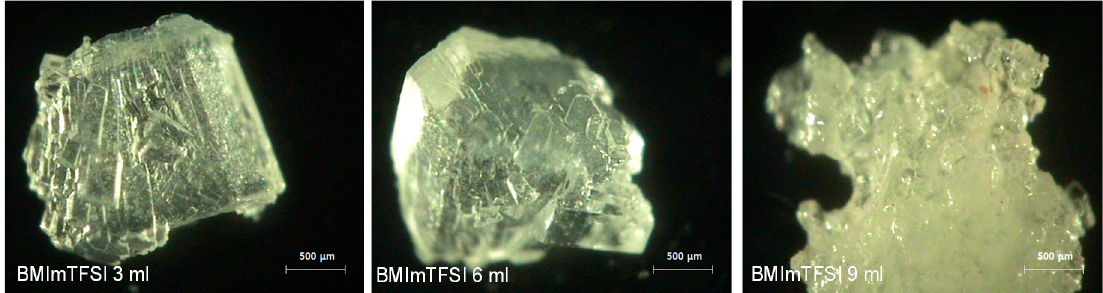
Figure 7. Video microscope images of sucrose crystals produced from the MeOH extraction solution of A. gigas (solvent volume of 3 mL) under BMImTFSI anti-solvent concentration change conditions using crystallization methods.